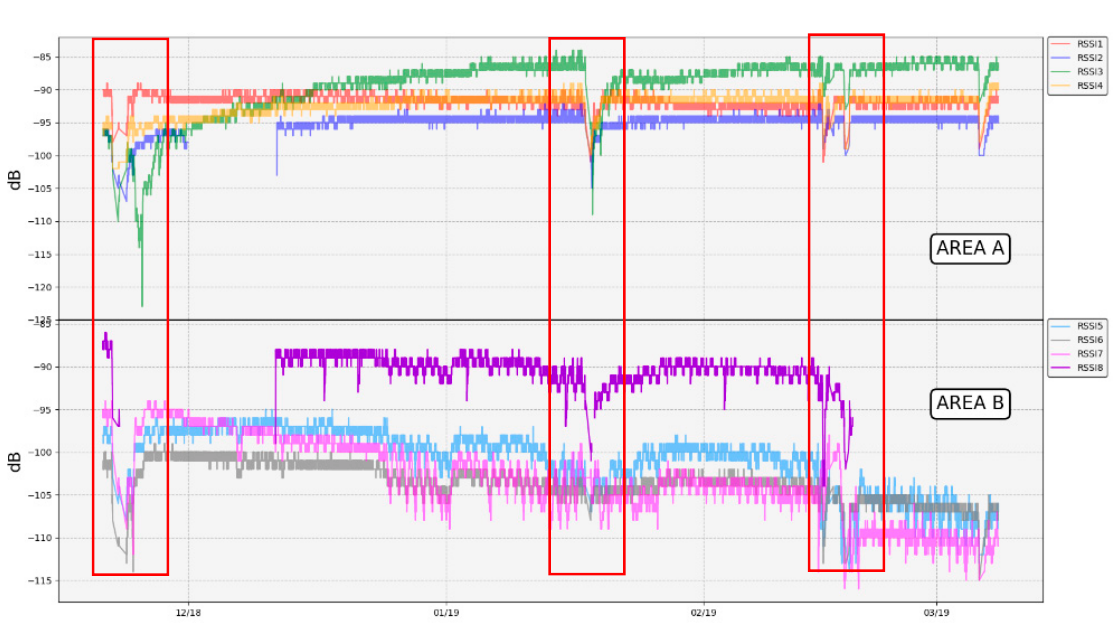
Figure 17. RSSI levels of each thermometer in areas A and B measured at the repeater side. Red rectangles point out periods in which the reception of packets in the repeater gets worse due to adverse weather conditions.